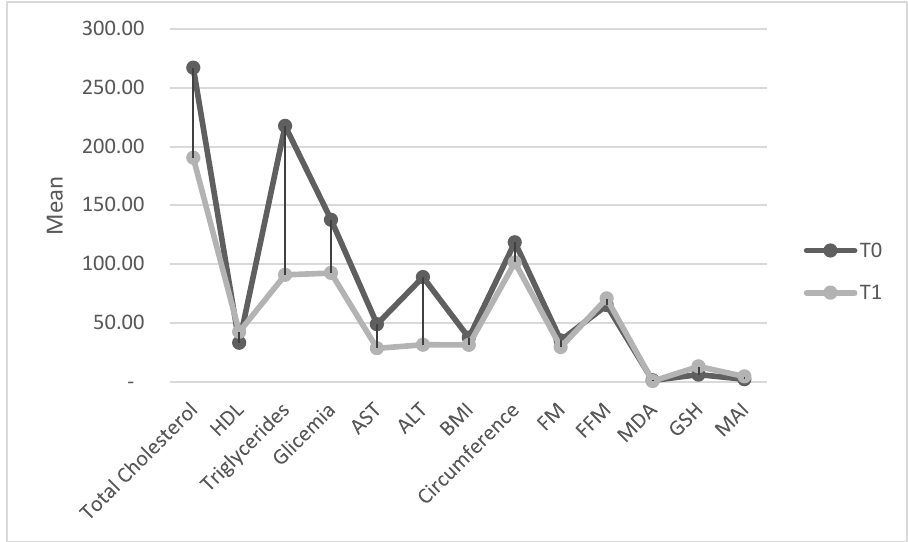
Figure 1. Scatter plots of clinical variables with lines linking the paired T0 and T1. The patients did not show a significant improvement in cognitive performance, measured with the MoCA, between T0 and T1. Spearman correlation showed a significant negative relationship between ALT and MAI (r = −0.48; p = 0.02) (Figure 2).